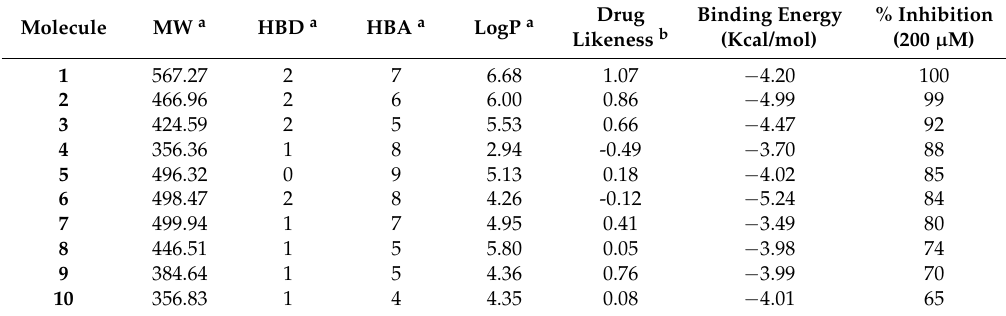
Table 1. The ten most potent PTP1B inhibitors.